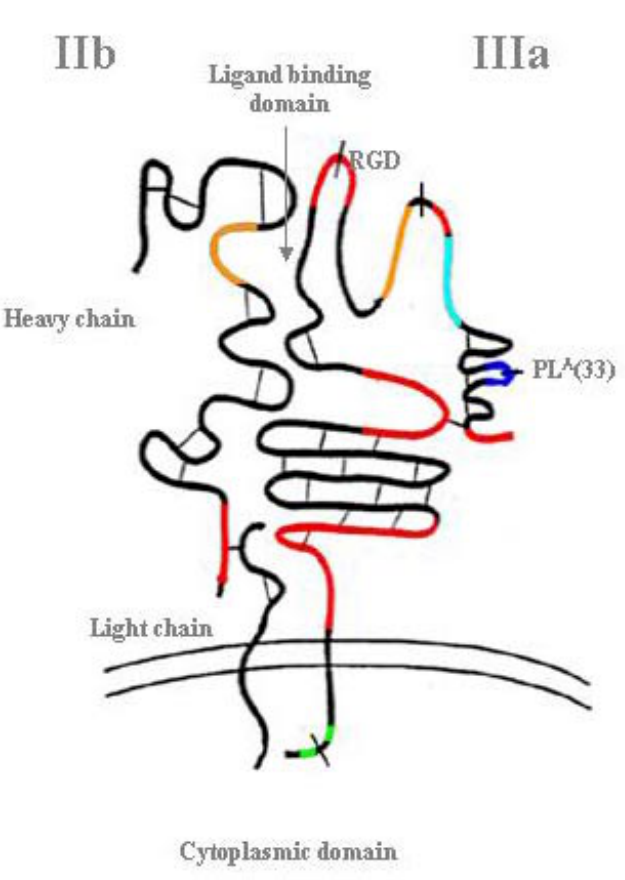
FIGURE 1. The GPIIb/IIIa receptor and Pl A polymorphism. The ligand binding site and RGD binding site are also